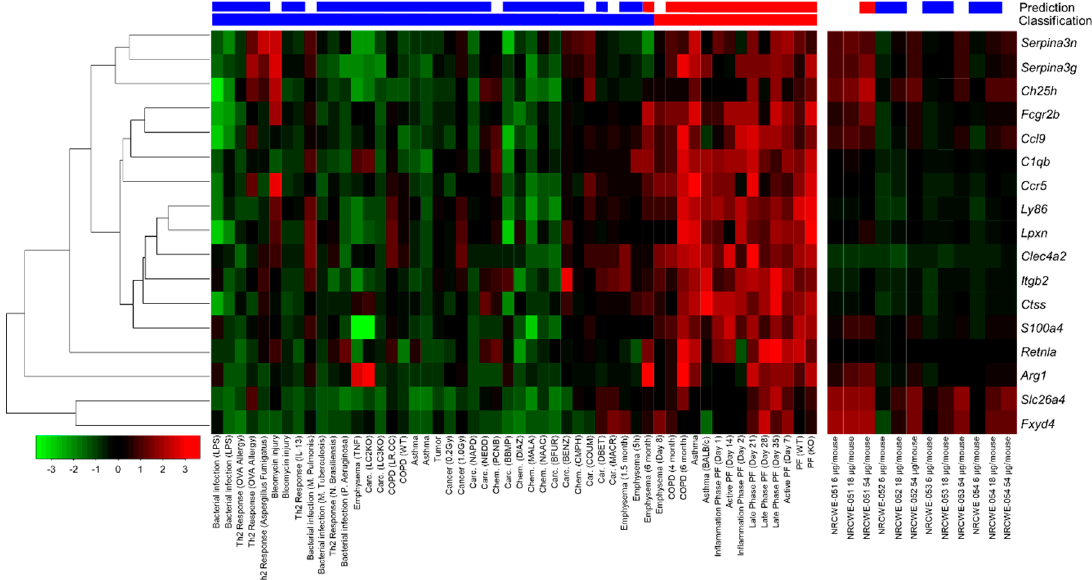
Figure 12. Pro-fibrotic transcriptomic signature after 1 day of exposure to NRCWE-051, NRCWE-052, NRCWE-053, and NRCWE-054. A heatmap that compares the transcriptomic profiles of lung-specific diseases vs. the pro-fibrotic transcriptomic signature (PFS17) [14] of lungs exposed to NRCWE-051, NRCWE-052, NRCWE-053, and NRCWE-054. Classification and prediction results are presented with blue (no-fibrotic), red (pro-fibrotic), or no color (unknown). The bottom bar represents the pre-classification of each study based on the literature data, and the top bar represents outcomes of prediction using PFS17. As described by Williams and Halappanavar et al. [67], bi-clusters related to pulmonary diseases were identified from public microarray datasets. The pro-fibrotic signature was derived from one of the identified bi-clusters. Red: upregulated. Green: downregulated. Table S3 shows the list of pulmonary diseases identified from public microarray datasets [14].